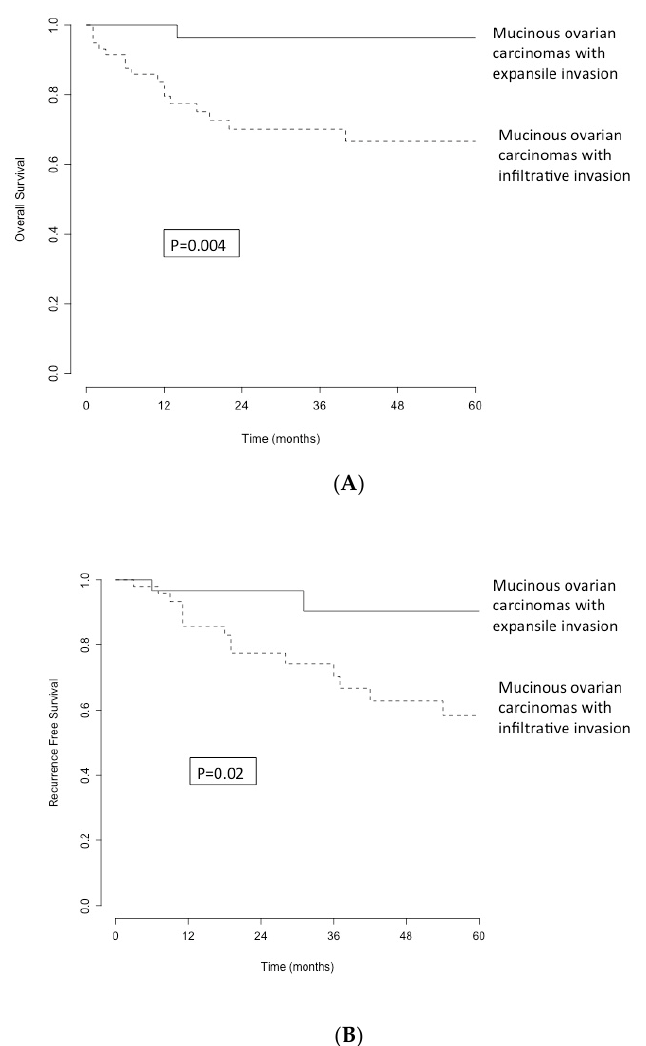
Figure 2. ( A ) Overall survival by histological type (straight line: expansile mOC; dashed line: infiltrative mOC). ( B ) Recurrence-free survival graph by histological type (straight line: expansile mOC; dashed line: infiltrative mOC).